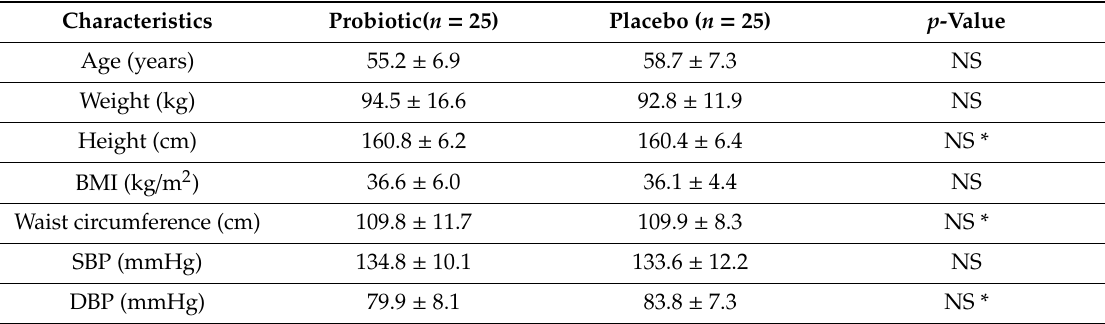
Table 1. Characteristics of the probiotic group and the placebo group at the beginning of the study.